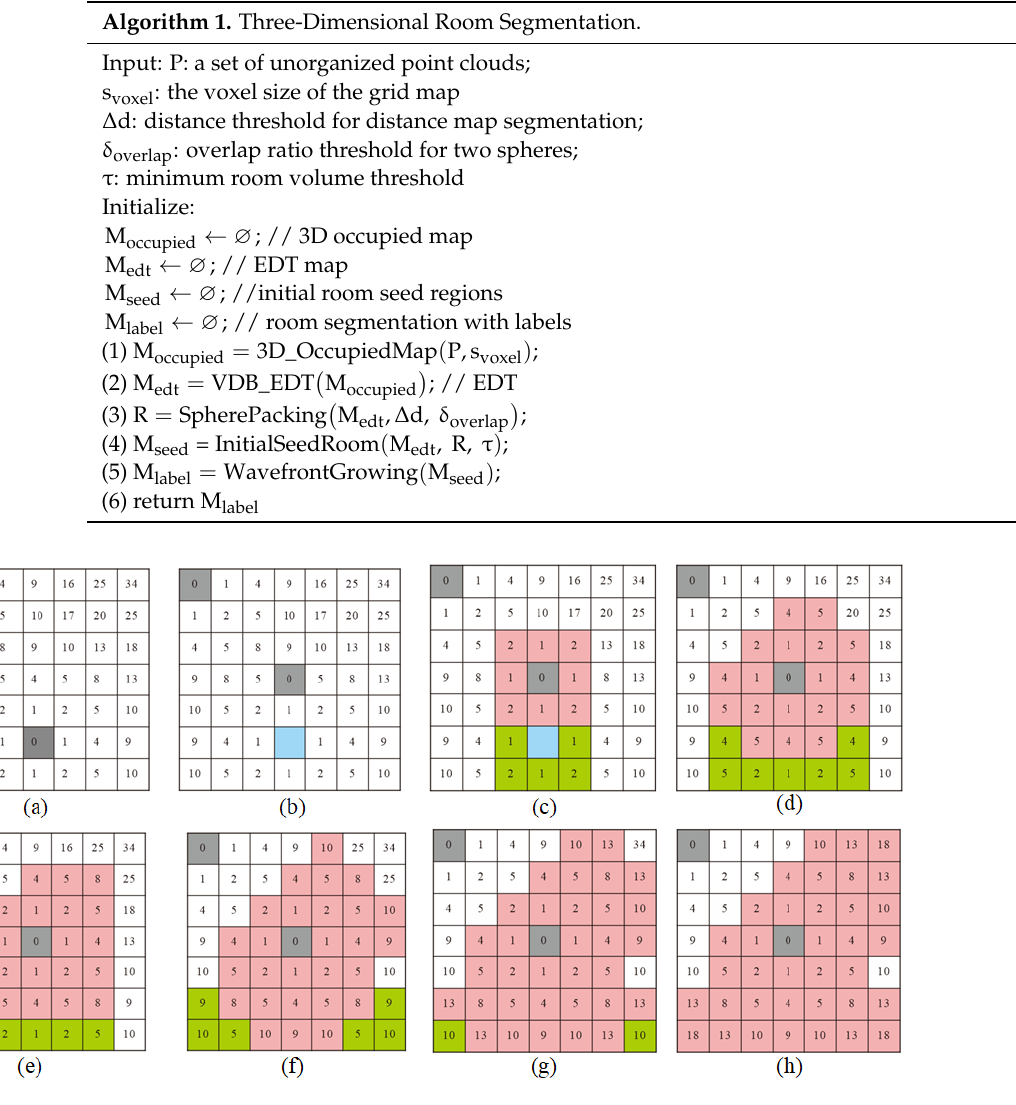
Figure 3. The VDB-EDT algorithm is performed to calculate the distance from each voxel to its nearest occupied point. The colours gray and blue correspond to occupied, empty values, respectively. The pink and green cells represent lowering and raising waves, respectively. ( a ) The initial map contains two occupied points; ( b ) the map contains a new occupied point and a newly cleared point; ( c – h ) the map contains the lowering and raising wavefronts with the highest current priorities. Algorithm 1 Three-Dimensional Room Segmentation